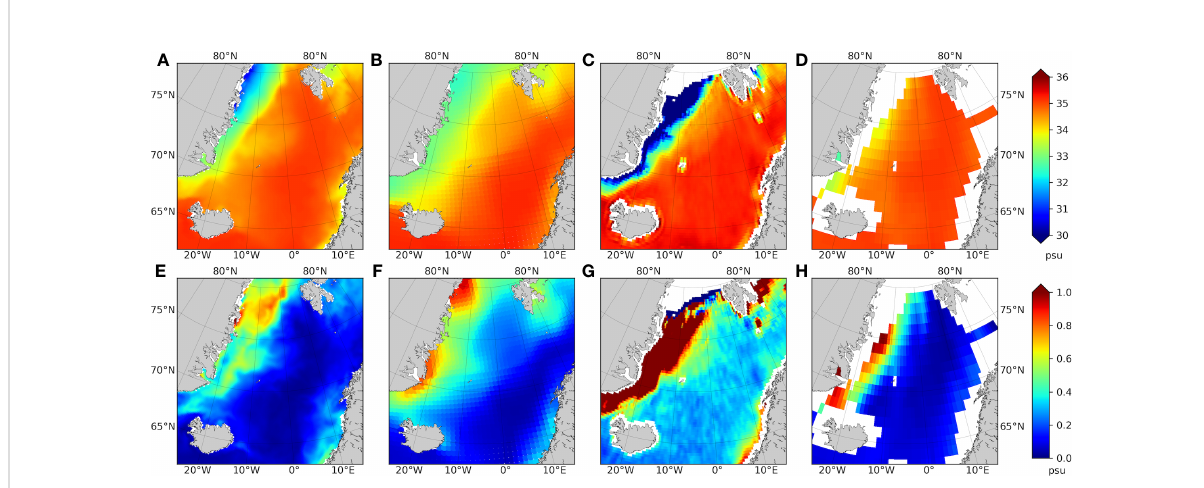
FIGURE 2 Temporal mean (top) and standard deviation (bottom) map of ocean salinity products from (A) , (E) TOPAZ4, (B) , (F) ECCOV4r4, (C) , (G) SMAP- RSS and (D) , (H) BOA-Argo data in the Nordic Seas for the period of